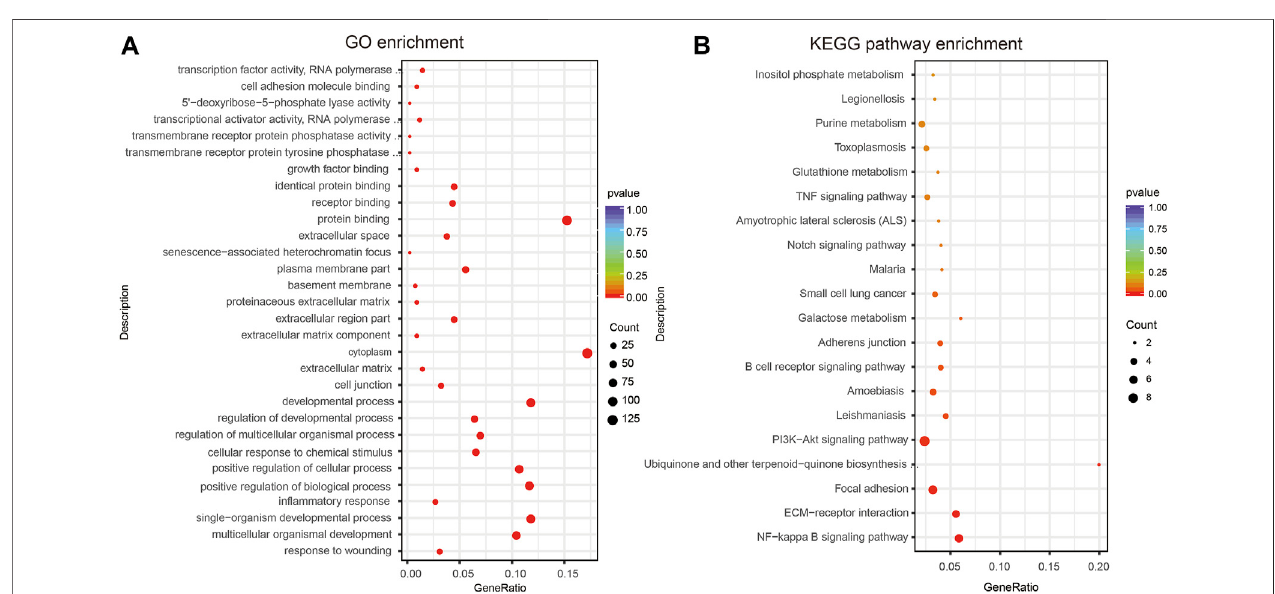
FIGURE6| GOandKEGGanalysesofDEmRNAsoftheceRNAnetwork. (A) TenmostabundantGOterms(BP,CC,andMF)relatedtoDEmRNAsparticipatingin ceRNAnetwork. (B) TwentymostenrichedKEGGcascadesrelatedtoDEmRNAsparticipatingceRNAnetwork.BP,biologicalprocess;LPS,lipopolysaccharide;NS,no lipopolysaccharide; DE, differentially expressed; CC, cellular